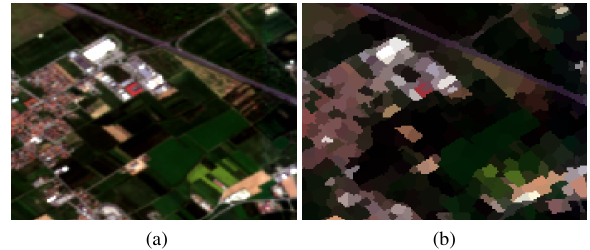
Figure 2: SLIC superpixels segmentation (a) Sentinel-2 RGB Im- age. (b) Segmented image, RGB values are averaged over each segment.